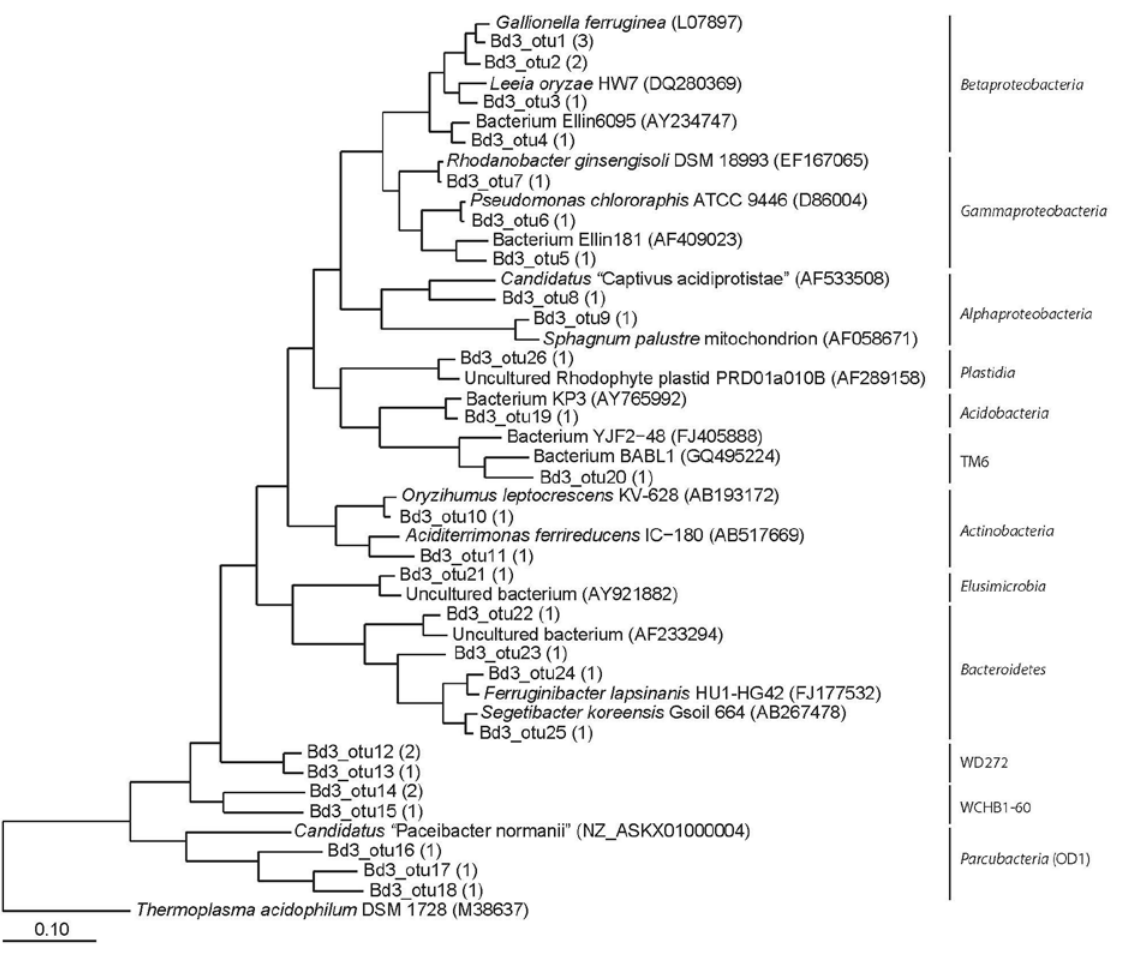
Figure A3. Phylogenetic affiliation for 16S rRNA gene sequences obtained from the Bjørndalen library (Bd3). Representative clones for different phylotypes were selected, retrieved from the sediment and water downstream the spring site. A maximum parsimony tree was chosen as a consensus tree after reconstructing the phylogeny by using different algorithms, substitutions models, and filters. Related isolates or environmental sequences are shown for comparison purposes. Bar represents 10% estimated phylogenetic